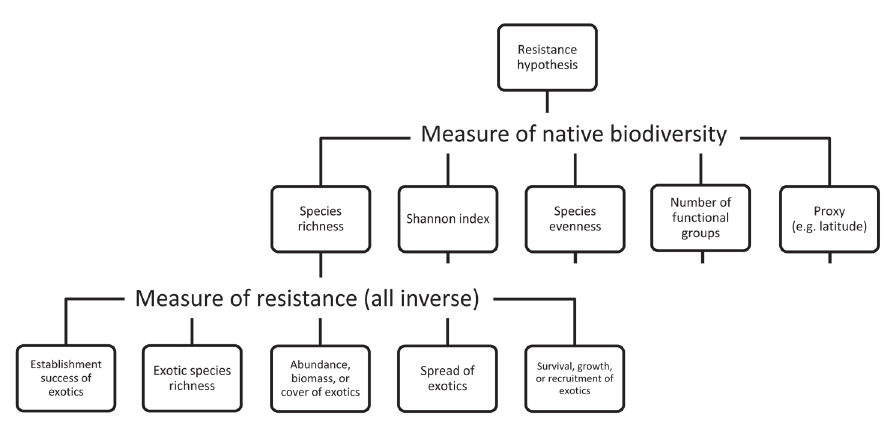
Figure 1. Example of a hierarchy of hypotheses. The biotic resistance hypothesis (as defined in the main body text) can be divided into sub-hypotheses according to the different measures (and thus definitions) of native biodiversity and resistance against invaders. Note that all measures of resistance typically applied are inverse measurements: the quantity measured reflects the susceptibility of ecosystems against invaders, so its inverse reflects resistance against invaders. Each of the five sub-hypotheses corresponding to dif- ferent measures of biodiversity branch into five sub-sub-hypotheses corresponding to different measures of resistance against invaders. For illustrative purposes, the second branching is only shown for one sub- hypothesis (species richness as a measure of